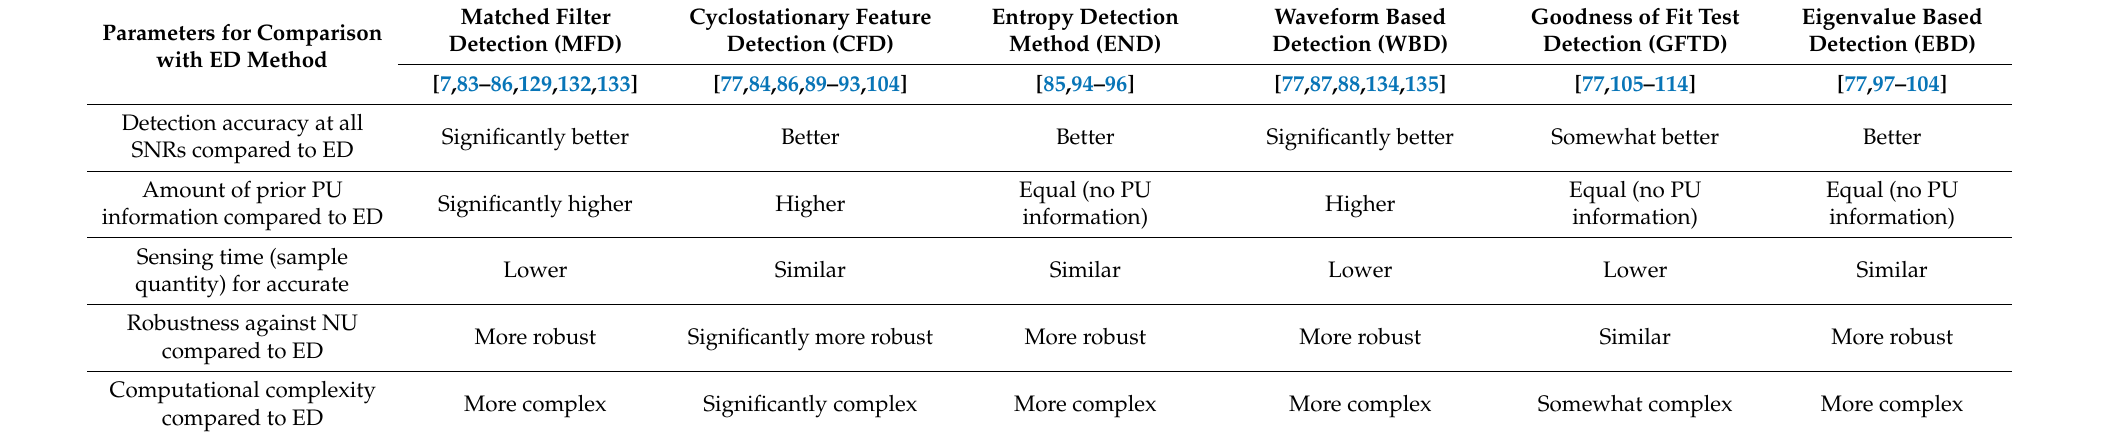
Table 5. Comparison of main performance parameters among ED and other non-cooperative SS